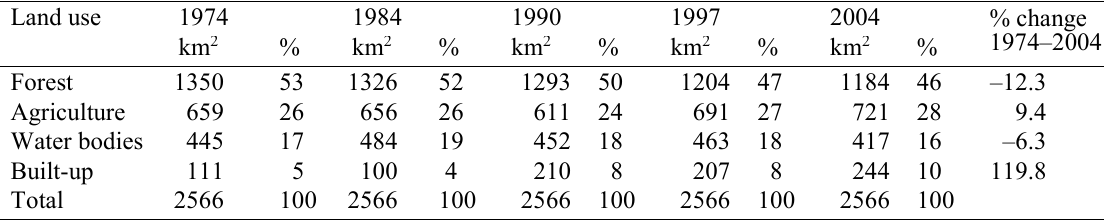
Table 1 Changes of land-use area in Kinta River catchment (km 2